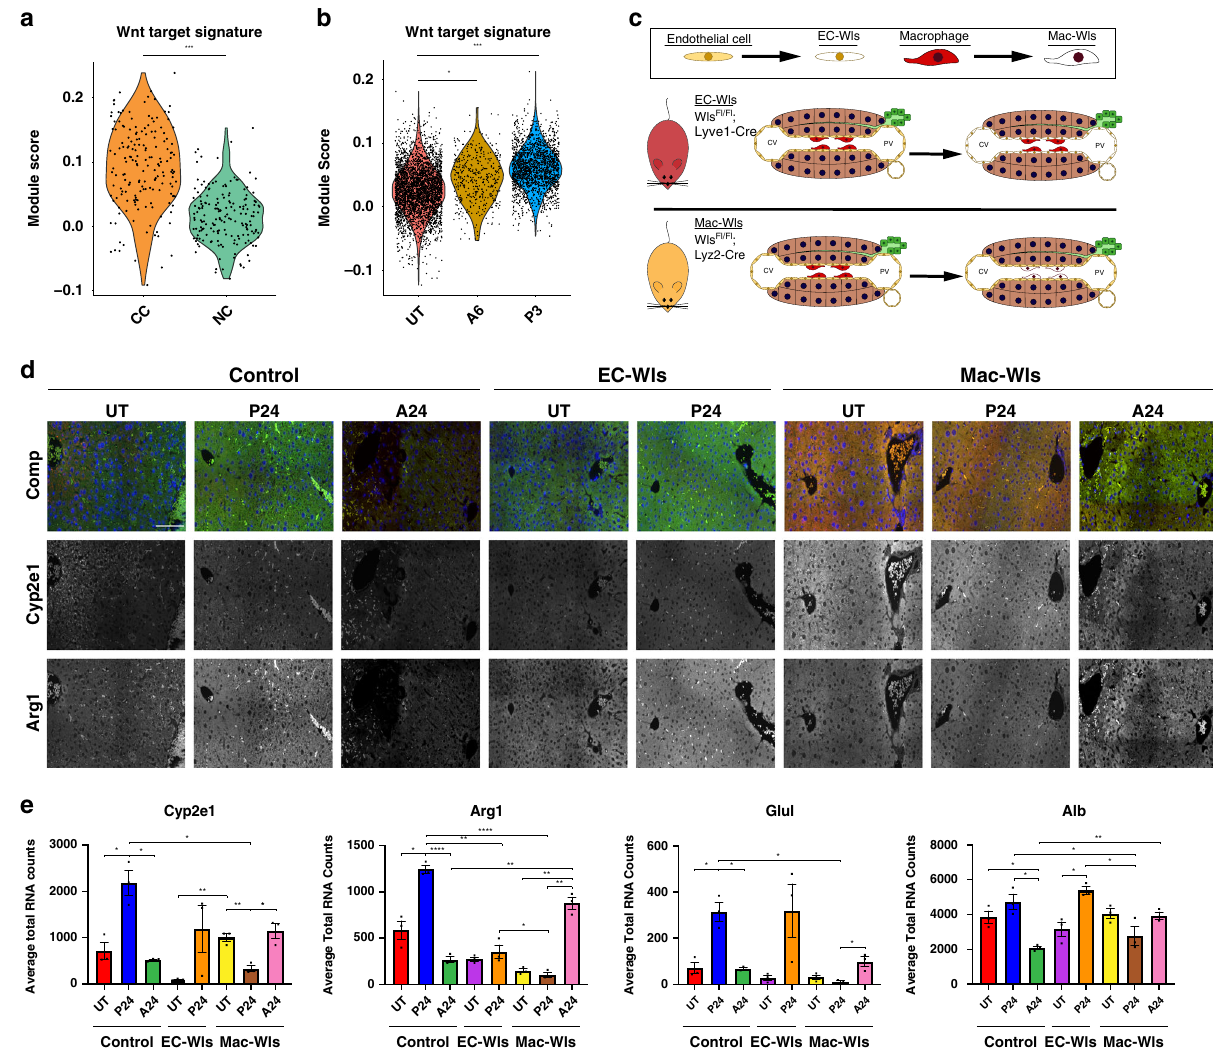
Fig. 5 Contribution of Wnt signaling to functional compensation of hepatocytes. Wnt target gene expression score over cycling cells (CC) and non- cycling cells (NC) from A24 and PH48 ( a ) and hepatocytes grouped by treatment condition (UT, A6, and P3) ( b ). c Wnt knockout mouse models. d Hepatocyte marker expression ( Alb and Arg1 ) in untreated, P24, and A24 for wild type (Control), endothelial cell Wntless KO (EC-Wls), and macrophage Wntless KO (Mac-Wtls) by smFISH. Representative image taken from three independent liver lobules. Scale bar is 100 μ m. ( e ) Average RNA expression of hepatocyte markers ( Alb , Arg1 , Cyp2e1 , and Glul ) in untreated, P24 hr, and A24 for WT, EC-Wls, and Mac-Wtls by smFISH. smFISH quanti fi cation shown as bar plot with individual replicates presented as dots ( n = 3). Error bars represent s.e.m., P < 0.05 (*), < 0.005 (**), < 0.0005 (***), and < 0.0001 (****) calculated using unpaired t tests with Welch ’ s correction (two-tailed). Source data provided as a Source Data fi